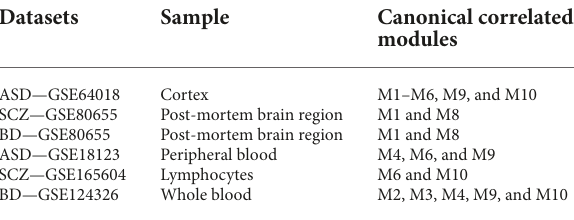
TABLE 2 Modules showing moderate to high preservation and significant canonical correlation of lncRNAs and mRNAs in the test post-mortem brain and blood-based